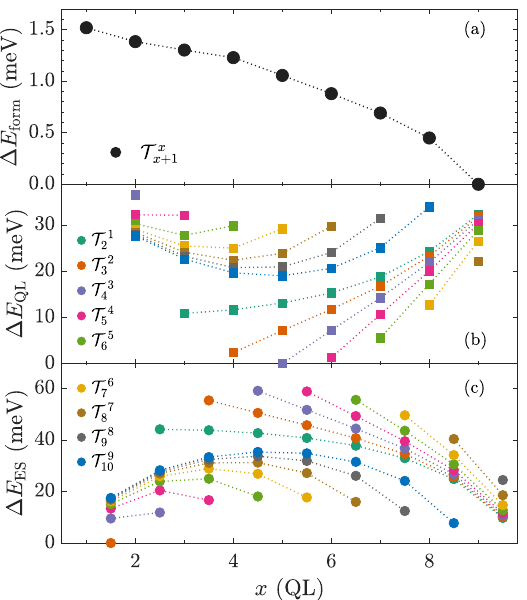
Figure A1. ( a ) Single TP relative formation energy ∆ E form as a function of the TP position x in the Bi 2 Se 3 multilayer. ( b ) Relative energy contribution ∆ E QL of the particular QL x . ( c ) Relative energy contribution of ES as a function of their position. Bi 2 Se 3 multilayer consists of 10 QLs. Concerning plots (b) and (c), dependencies belonging to several locations of TPs are depicted, where data points in the vicinity of TPs are excluded for